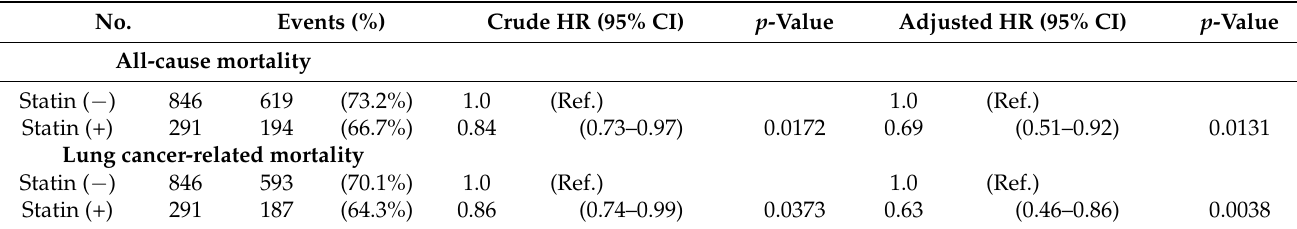
Table 2. Cox proportional-hazards model of all-cause mortality and lung cancer-related mortality among NSCLC stage IV patients with cancer-related pleural effusion with and without statin